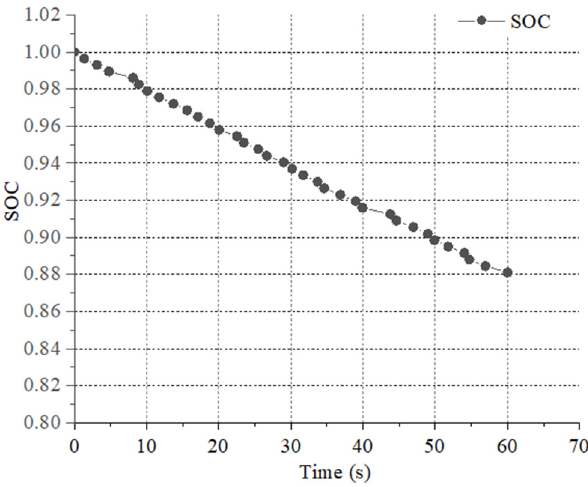
Figure 22. Battery